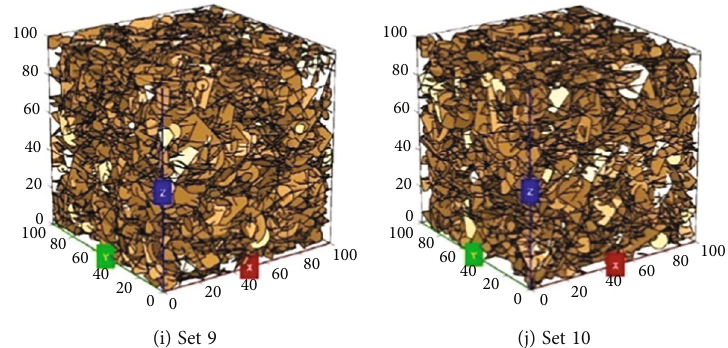
Figure 7: DFN models generated using ten sets of random number seeds.